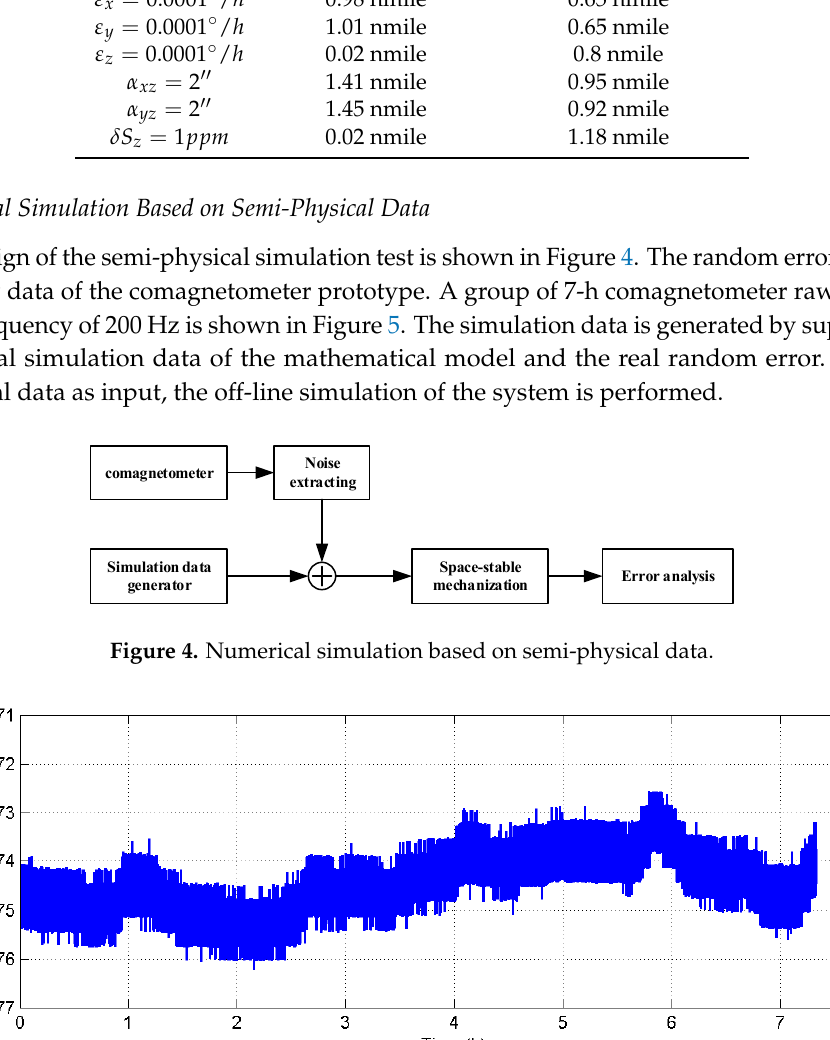
Table 2. Max position error in numerical simulation of the mathematical model.